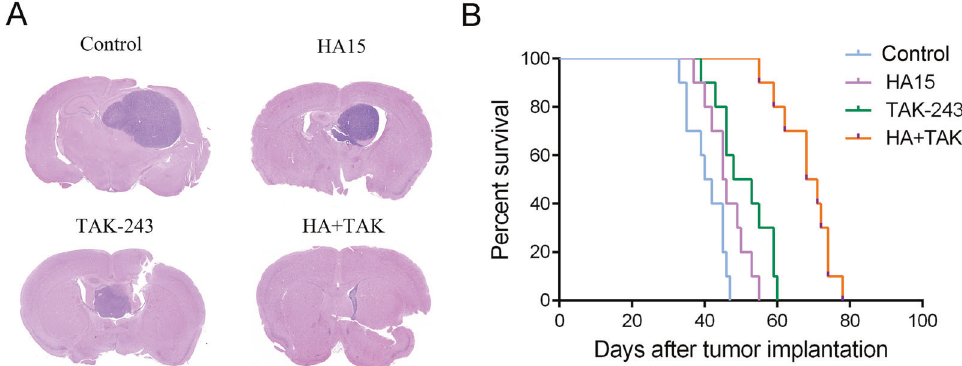
Fig. 5 HA15 combined with TAK-243 can slow down the growth of xenograft tumor in nude mice and prolong the survival of tumor- bearing mice. A Mice bearing U87-drived xenograft tumor were treated with TAK-243 and/or HA15. Representative images of H&E staining of whole brain sections from control group and TAK-243 and/or HA15 treatment groups. B The survival analysis of mice with TAK-243 and/or HA15